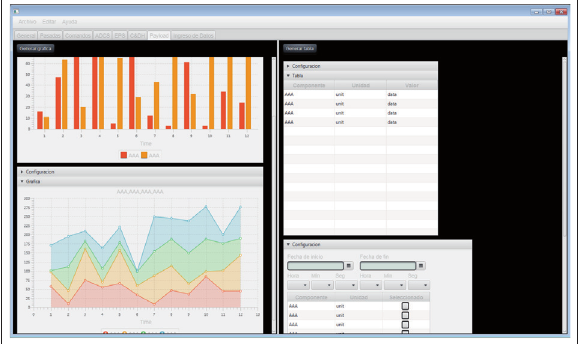
figure 19. Charts view on the GSCM&C monitoring